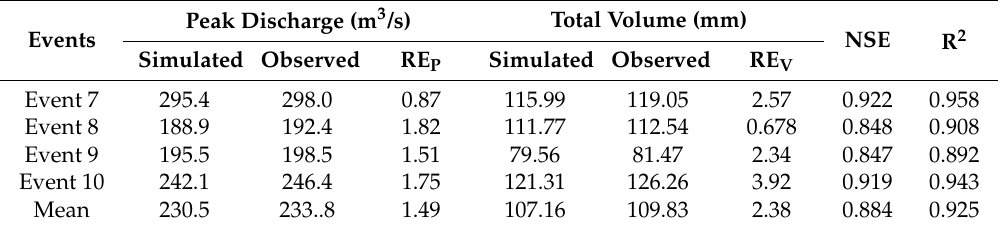
Table 6. Simulated and observed peak discharge and total volume during